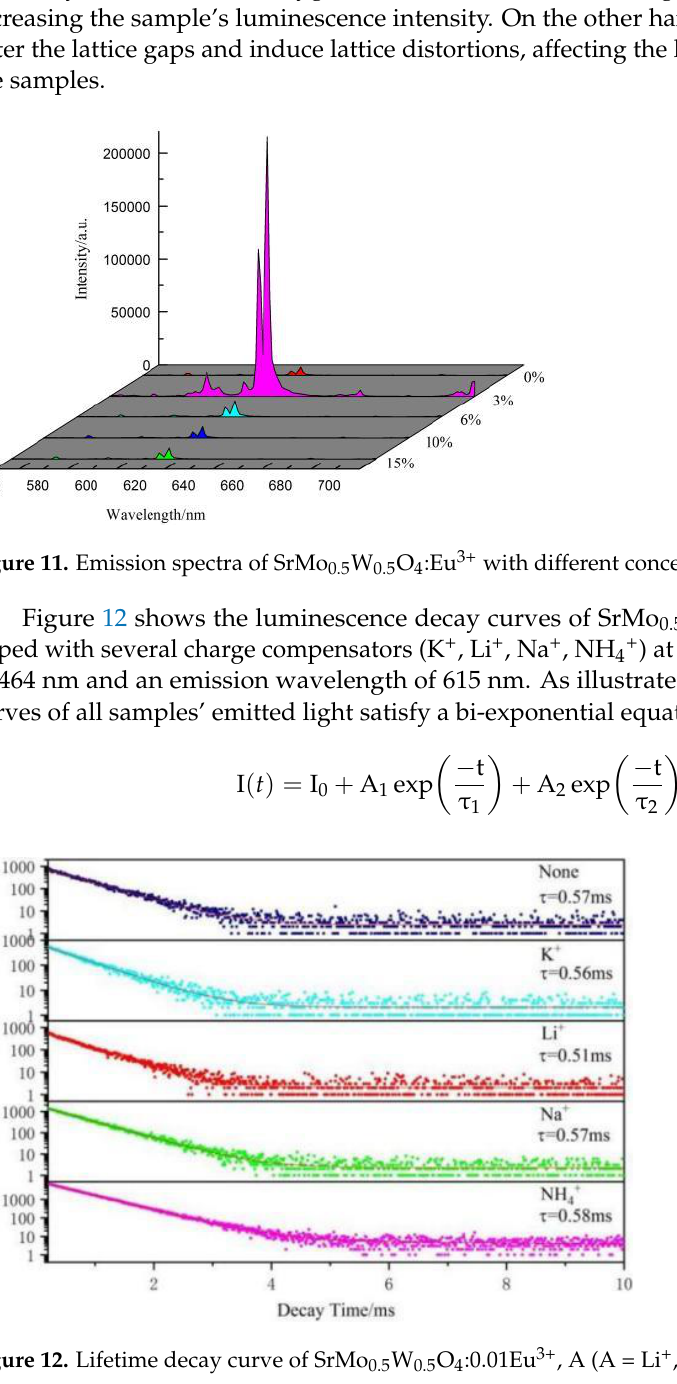
Figure 11. Emission spectra of SrMo 0.5 W 0.5 O 4 :Eu 3+ with different concentrations of NH 4+ .